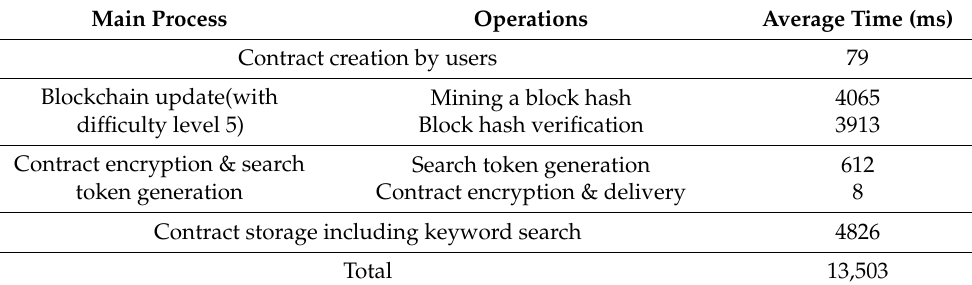
Table 7. Summary of the total execution time.